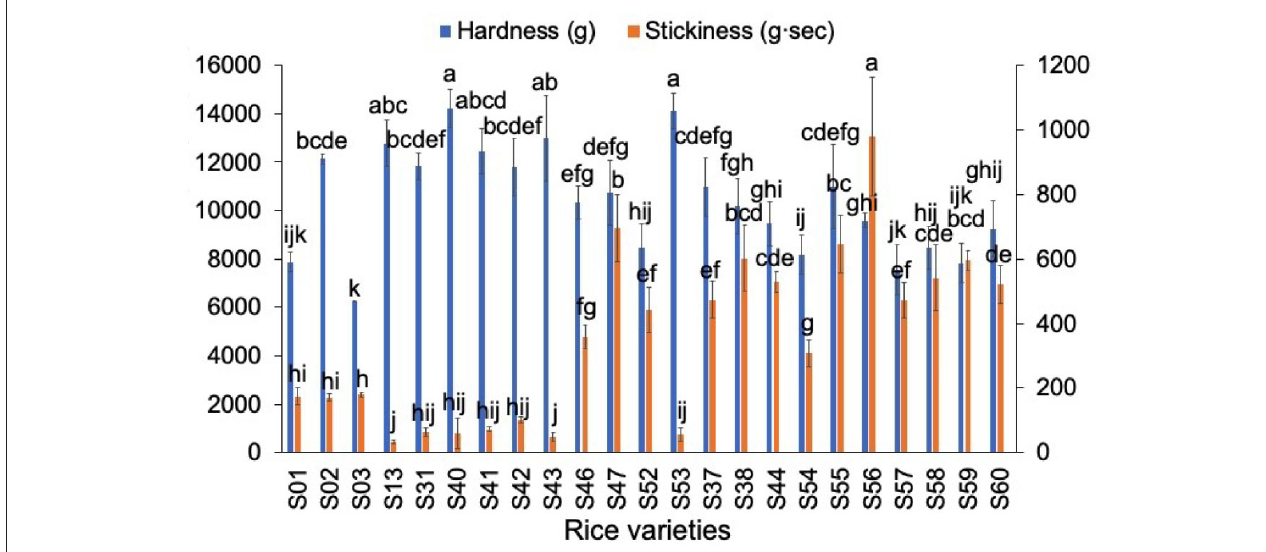
FIGURE 4 | Comparison of textural parameters of Australian Wild Rices (AWRs) and Domesticated Rices (DRs). AWRs consist of S01–S03, indica variety contains S13, S31, S40–S43, S46–S47, S52–S53 and japonica variety contains S37–S38, S44, S54–S60, respectively. All data were from five times measurements. The same letters mean no significant difference ( p < 0.05).